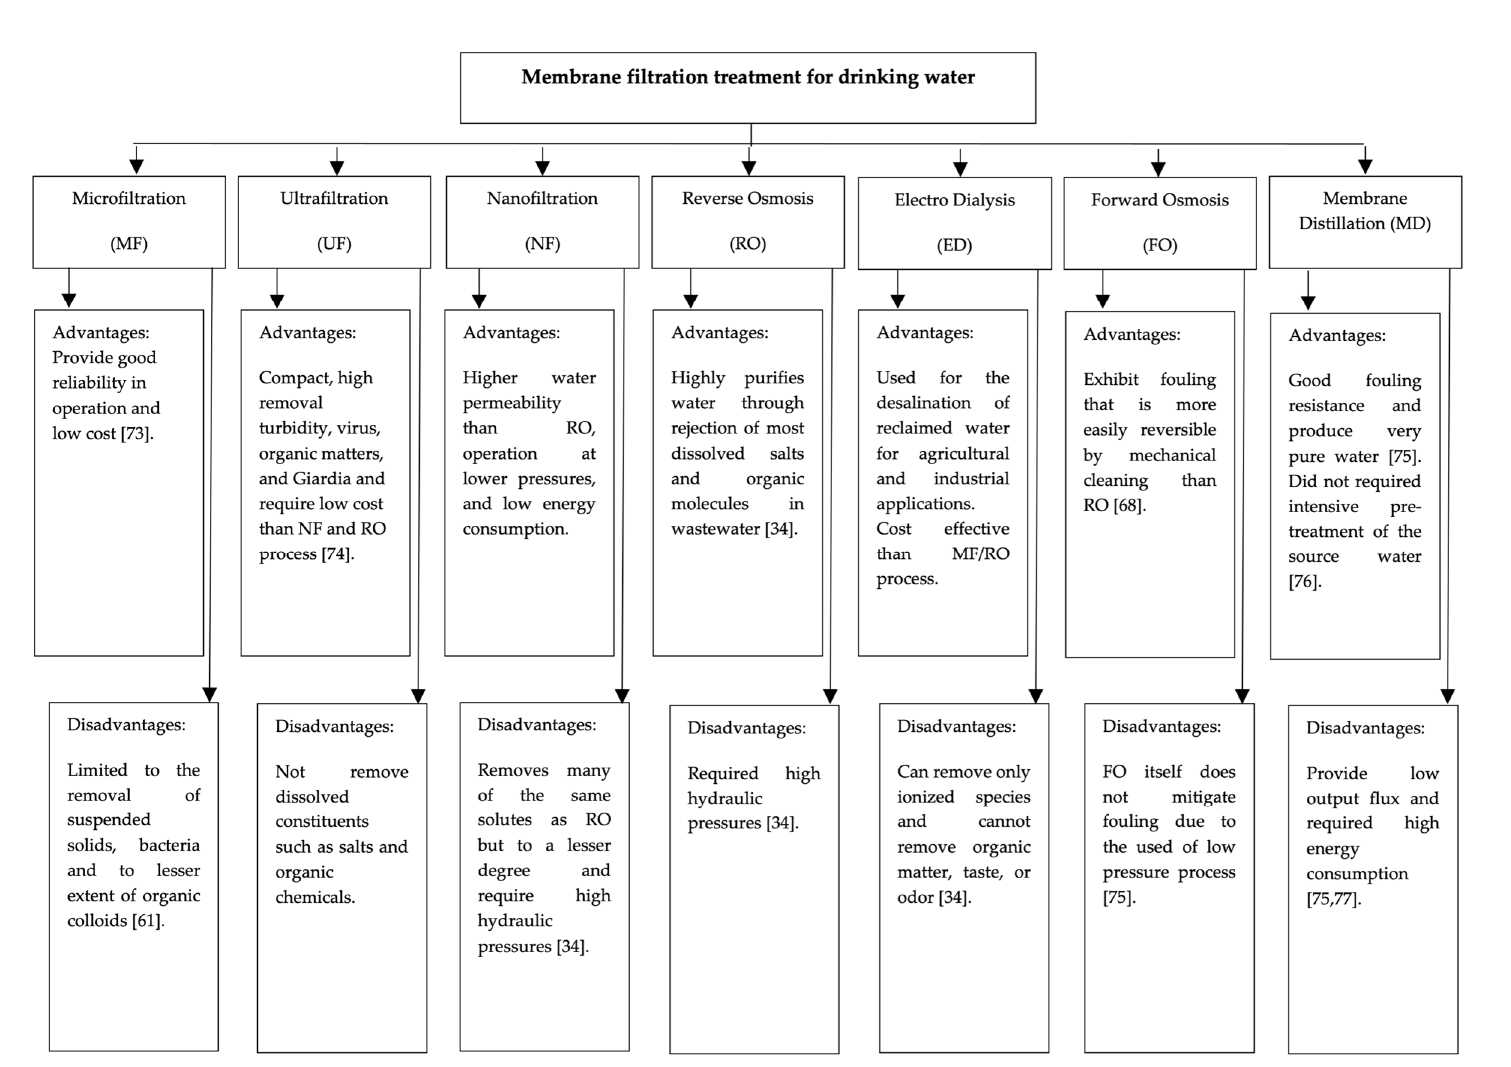
Figure 3. Available membrane filtration treatment for drinking water [34,61,68,72–77].